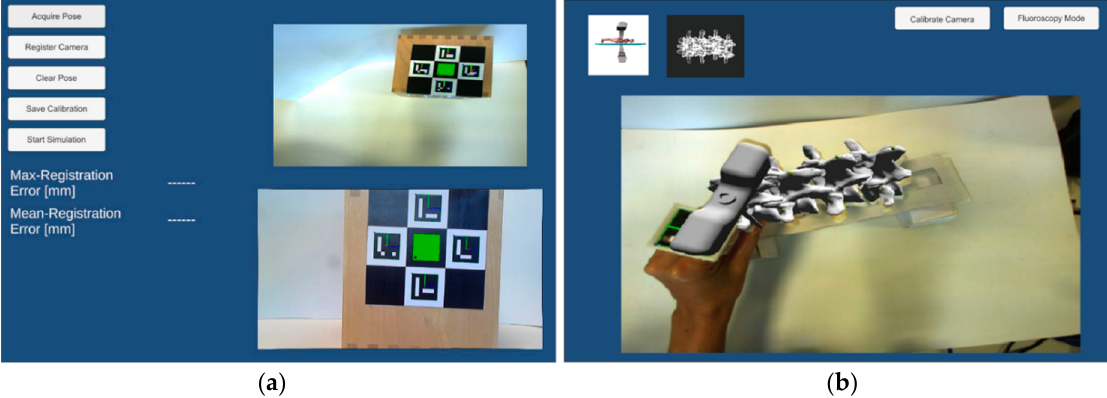
Figure 7. Screenshots of the User Interface: ( a, left ) the User Interface during a calibration procedure; ( b, right ) the User Interface during a simulation session. This second screenshot shows both the virtual fluoroscopic image (from the selected Virtual C-Arm pose) and the AR view from the top camera (Cam Top ).